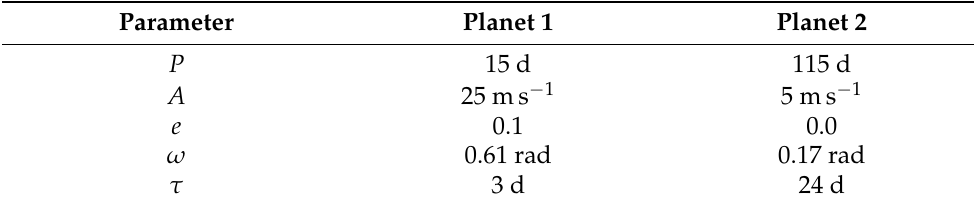
Table 3. Main orbital parameters of the two exoplanets in the